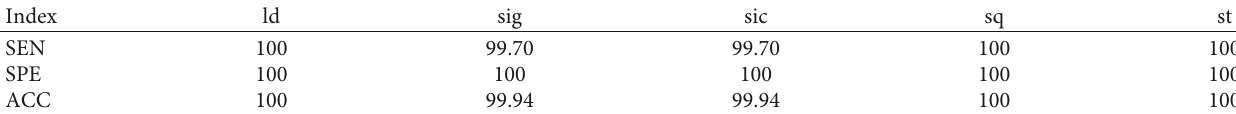
Figure 10: F2 of sic and sig. Table 5: Recognition results of posture activities (%).